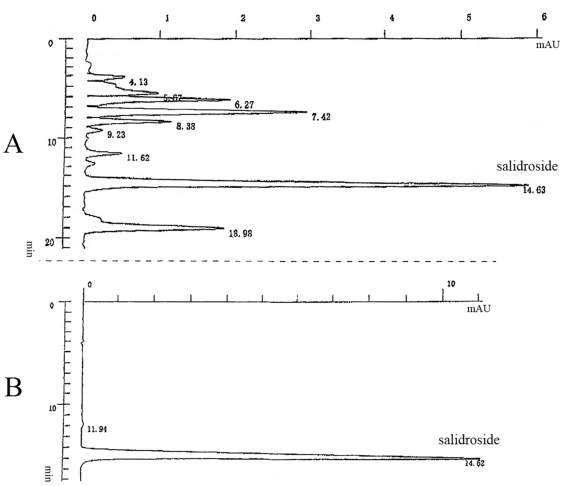
Analytical HPLC chromatograms.(A) R. crenulata extract (RCE); (B) salidroside control. Note that salidroside is the most abundant ingredient of the RCE.